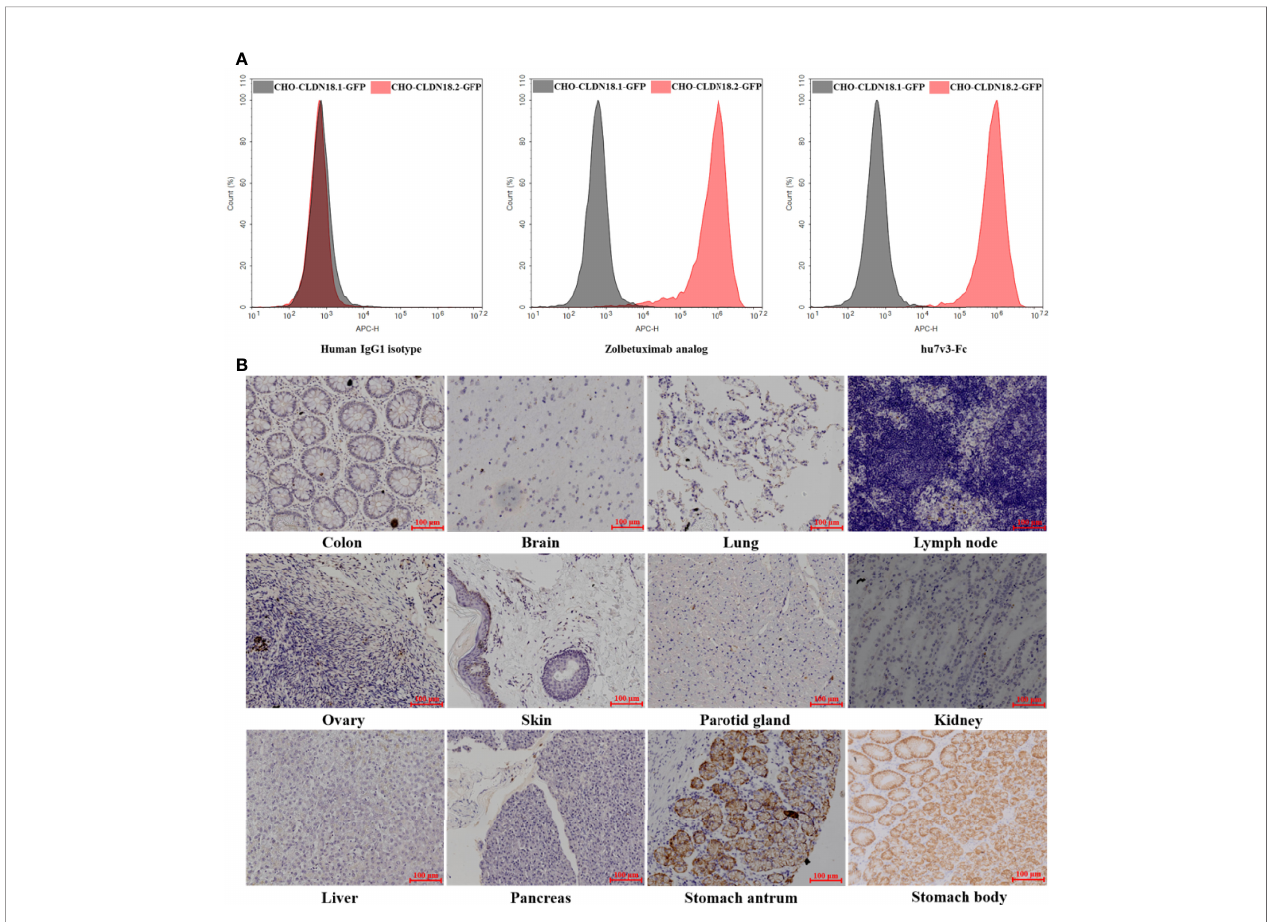
FIGURE 2 | Characterization of anti-CLDN18.2 hu7v3-Fc. (A) Flow cytometric analysis to determine the speci fi city of hu7v3-Fc to CLDN18.2. Zolbetuximab was employed as the positive control antibody, and human IgG1 isotype as the negative control antibody. CLDN18.1 and CLDN18.2 was co-expressed with GFP in CHO-CLDN18.1-GFP and CHO-CLDN18.2-GFP cells, respectively. (B) IHC analysis to determine the speci fi city of hu7v3-Fc to CLDN18.2. Frozen sections of colon, brain, lung, lymph node, ovary, skin parotid gland, kidney, liver, pancreas, stomach antrum and stomach body were obtained from healthy tissue in The